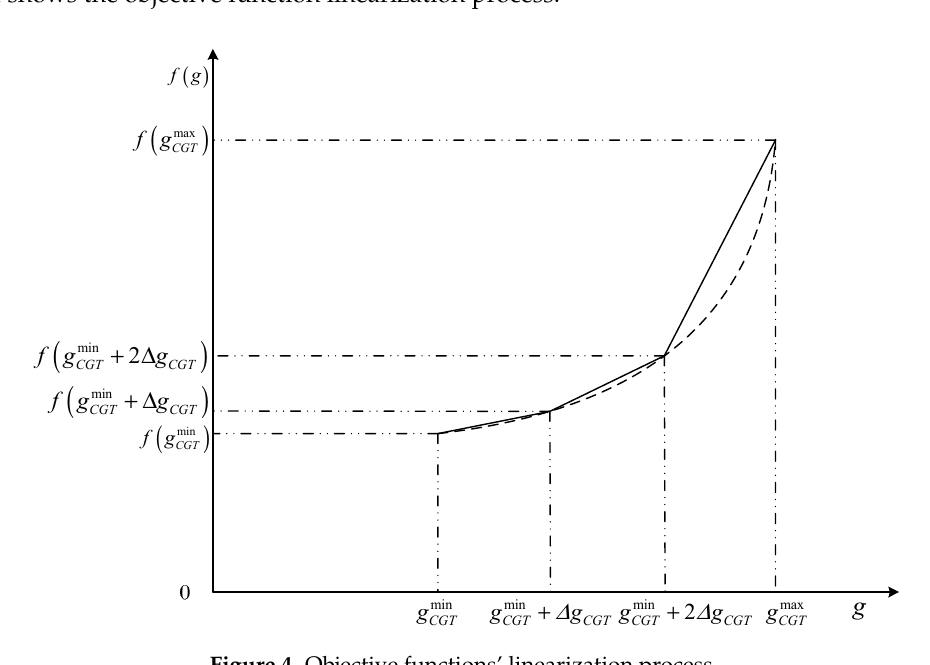
Figure 4. Objective functions’ linearization process.